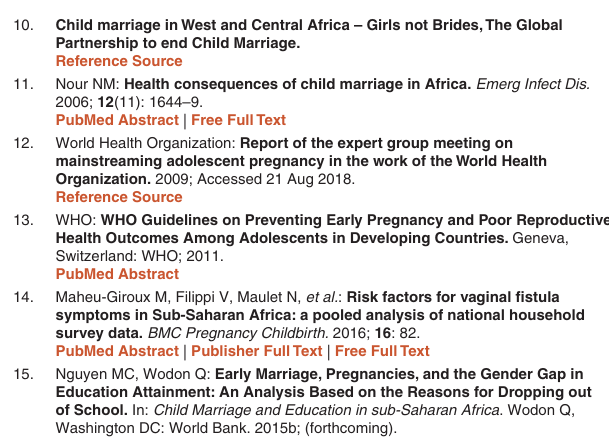
Figshare: Social and cultural factors perpetuating early marriage in rural Gambia: an exploratory mixed methods study. https://doi.org/10.6084/m9.figshare.10046024.v1 37 . This project contains the focus group discussion guide. Figshare: Social and cultural factors perpetuating early marriage in rural Gambia: an exploratory mixed methods study. https://doi.org/10.6084/m9.figshare.10046090.v1 34 . This project contains the questionnaire administered to the female adolescents. Figshare: Social and cultural factors perpetuating early marriage in rural Gambia: an exploratory mixed methods study. https://doi.org/10.6084/m9.figshare.10046102.v1 35 . This project contains the household